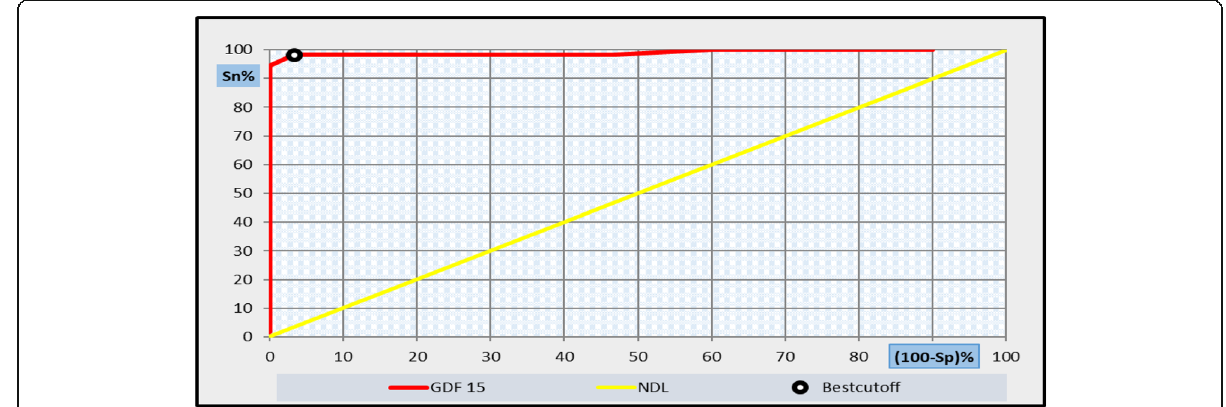
Fig. 5 Receiver operating characteristic curve (ROC) analysis showing the diagnostic performance of GDF-15 for discriminating HCV patients with liver fibrosis from those control with area under the curve (AUC) = 0.99